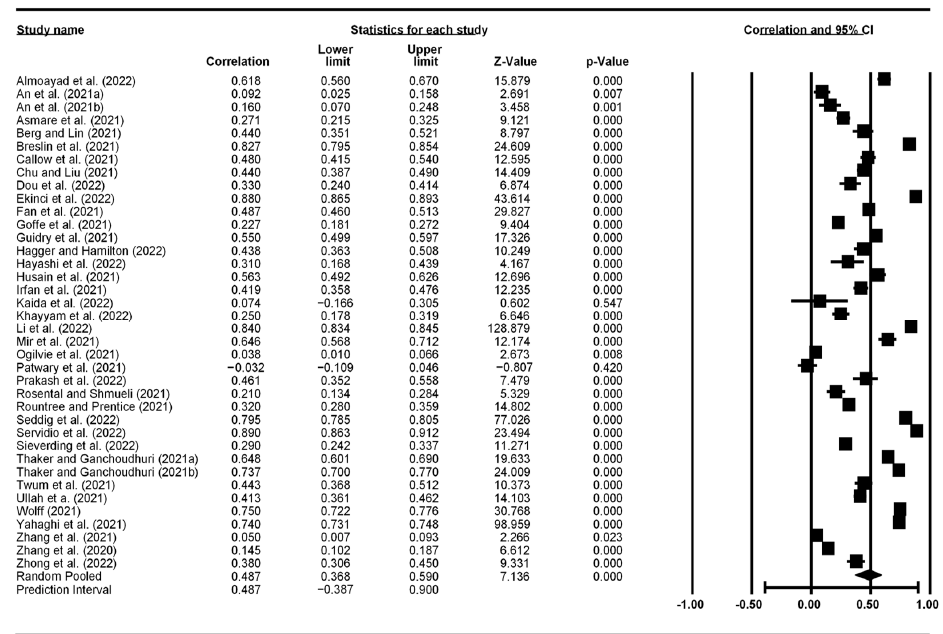
Figure 2. Forest plot showing attitude and vaccination intention correlation.